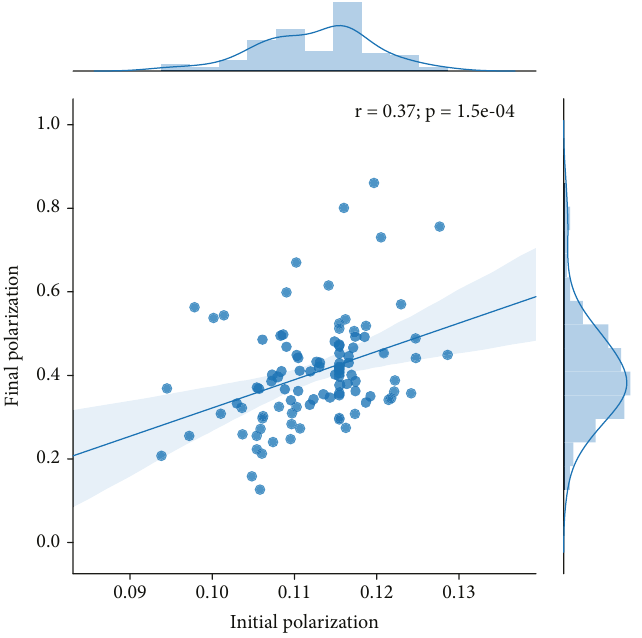
Figure 5: Regression of fi nal polarization against initial polarization for K = 2 in the nonrandom connected caveman network con fi guration. Final polarizations are same as in the K = 2 column of Figure 4(a). 100 trials are shown. The top histogram shows the distribution of initial polarization across trials. The right histogram shows the distribution of fi nal polarization across